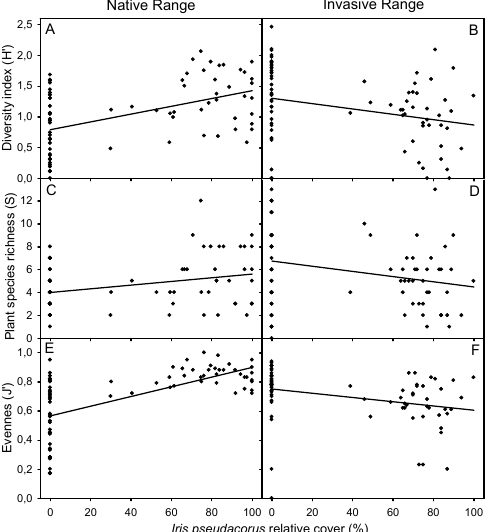
Figure 2. Relationship between the α -diversity (H’), plant species richness (S) and evenness (J’) with Iris pseudacorus relative cover in native (Guadalquivir Estuary) and invaded (San Francisco Bay-Delta Estuary) distribution ranges. Regression equations: ( A ) y = 0.7921 + 6.335 × (R = 0.429, p < 0.0001, n = 76); ( B ) y = 1.304 − 4.333 × (R = 0.274, p < 0.05, n = 78); ( C ) y = 4.012 + 0.016 × (R = 0.302, p < 0.01, n = 76); ( D ) y = 6.764 − 0.023 × (R = 0.252, p < 0.05, n = 78); ( E ) y = 0.567 + 3.333 × (R = 0.624, p < 0.0001, n = 75); ( F ) y = 0.752 − 1.453 × (R = 0.302, p < 0.01, n = 73). Shannon–Wiener α -diversity and number of plant species within I. pseudacorus patches increased together with their values recorded outside of occupied patches in both distribution ranges (Figure S2). In contrast, species evenness within I. pseudacorus patches only increased together with evenness outside of Iris patches in the native range (Figure S2). In addition, the differences in plant species diversity and richness between areas without and with I. pseudacorus increased together with values of diversity and richness without Iris , respectively, only in the invaded range; these relationships were non-significant for species evenness (Figure 3).